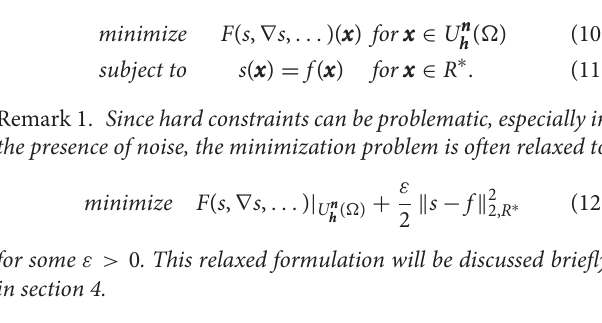
FIGURE 2 | Exemplary test data: cartoon-like images and natural